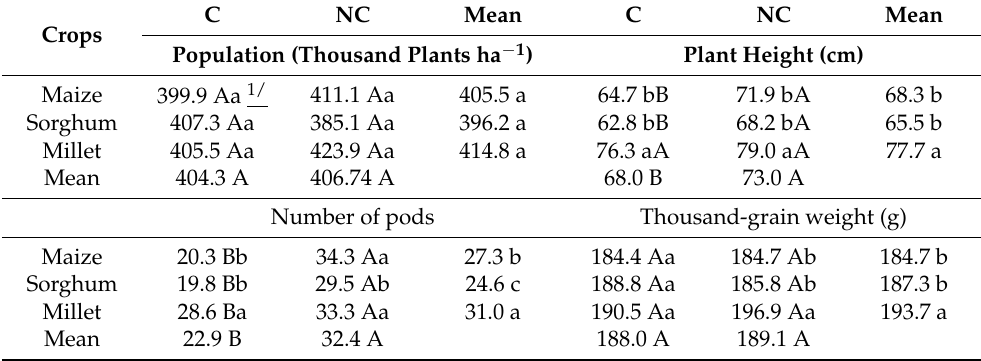
Table 3. Agronomic characteristics (plant population, plant height, number of pods per plant, and thousand-grain weight) of soybean cultivated after second-season crops of maize, sorghum, and millet in compacted (C) and uncompacted (NC)